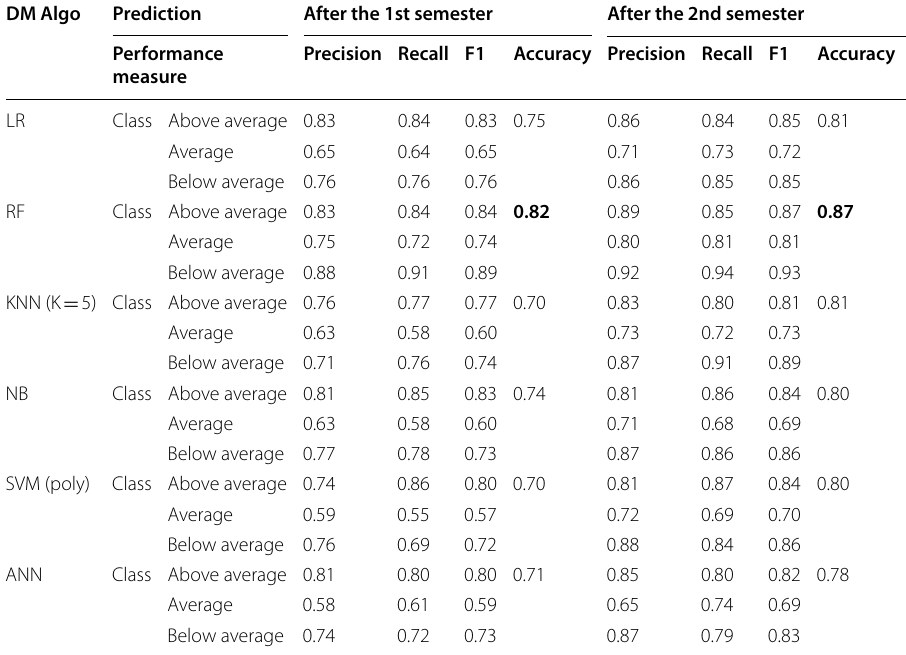
Bold values represent the results with best accuracies